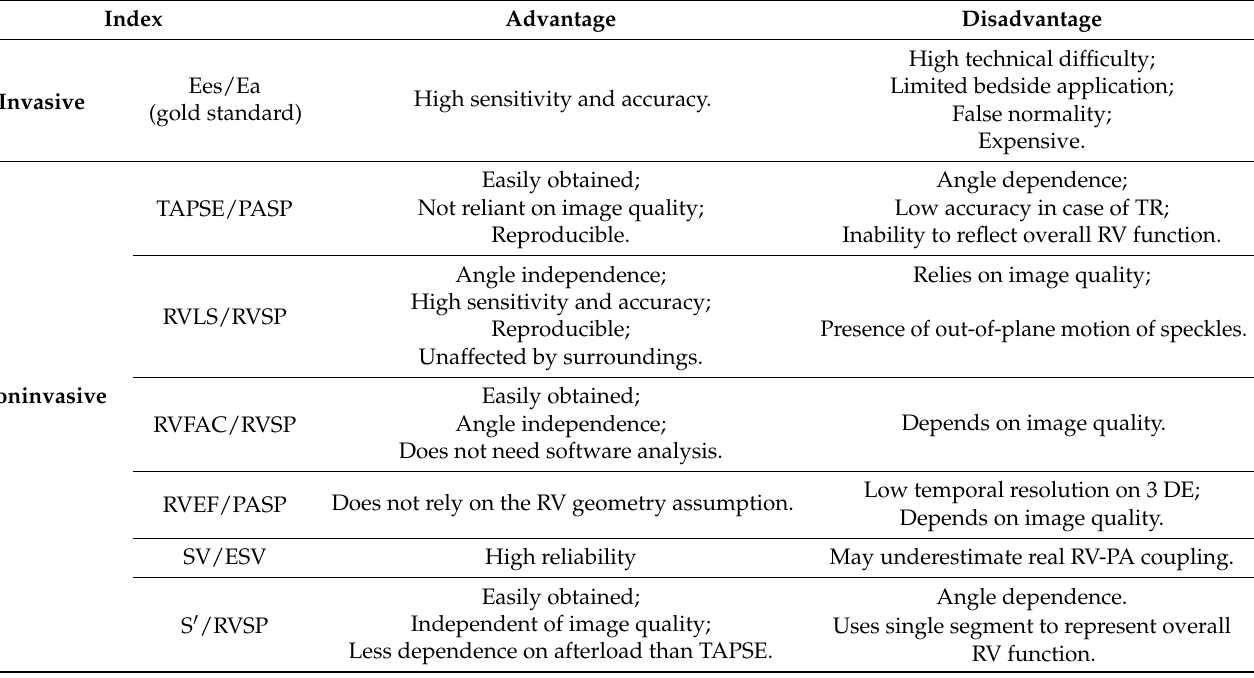
Table 1. Advantages and disadvantages of methods evaluating RV-PA